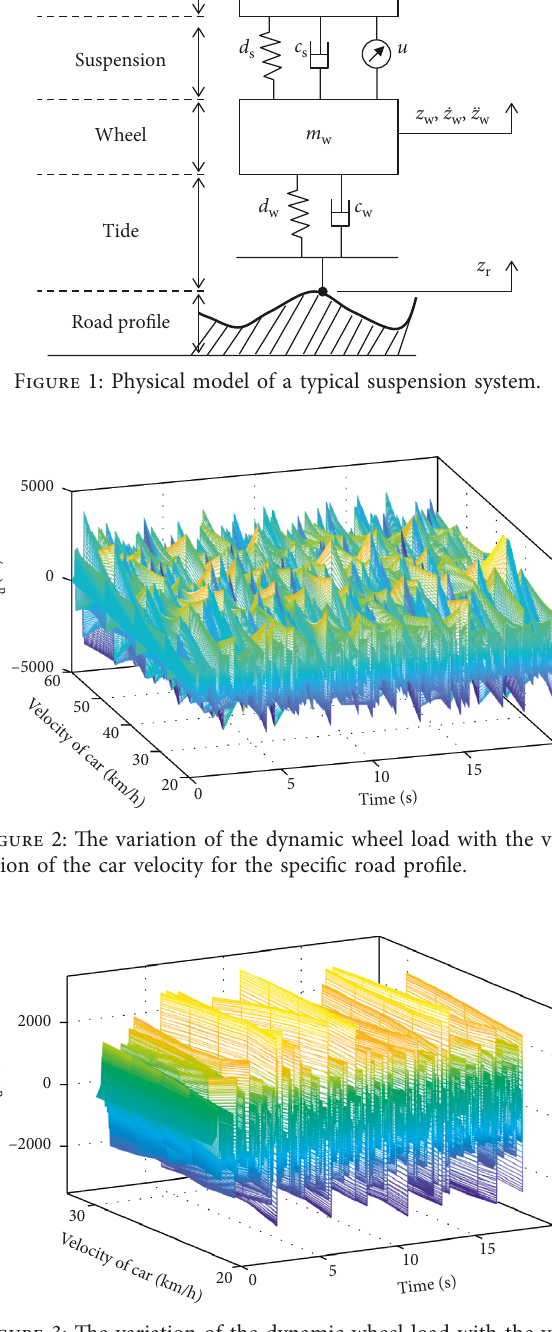
Figure 3: The variation of the dynamic wheel load with the var- iation of the car